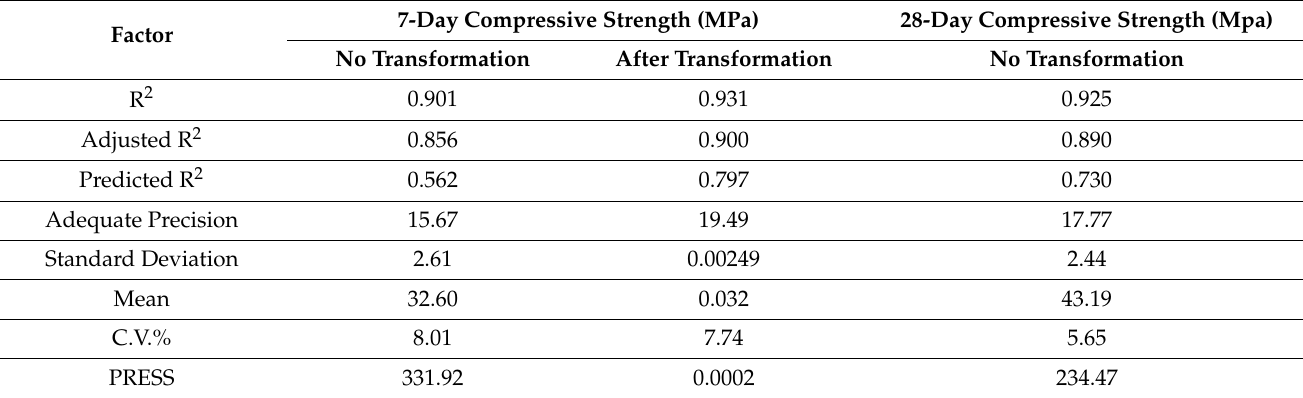
Table 7. Co-efficient of Regression ANOVA for Compressive Strength.